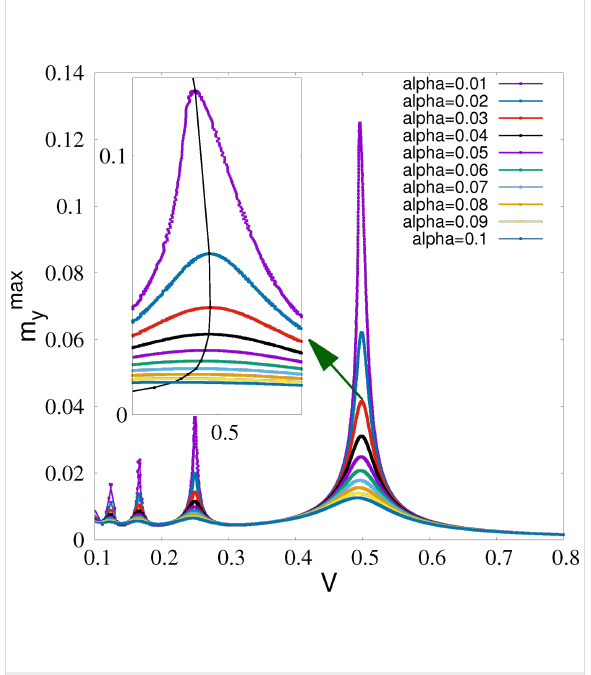
Figure 2: Maximal amplitude of magnetization m y -component at each value of voltage along the I – V characteristics of the φ 0 junction in the ferromagnetic resonance region for different α . The inset enlarges the main maximum. Parameters: β c = 25, G = 0.05, r = 0.05, and ω F =